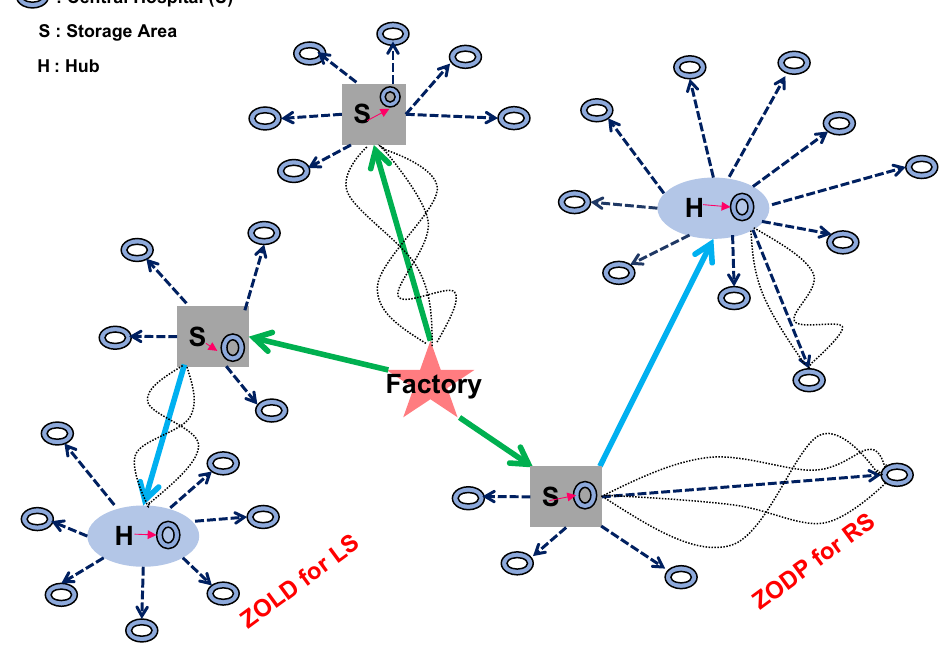
Figure 1. Diagram of a transportation management system for PD supplies.